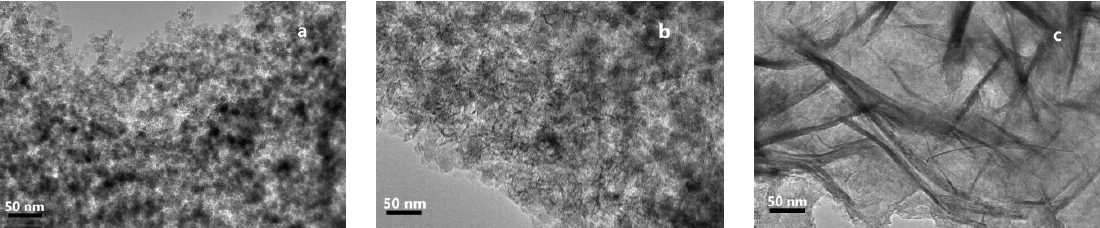
Figure 3. TEM images of ( a ) CuO / SiO 2 (IM), ( b ) CuO / SiO 2 (DP), and ( c ) CuO / SiO 2 (AE).